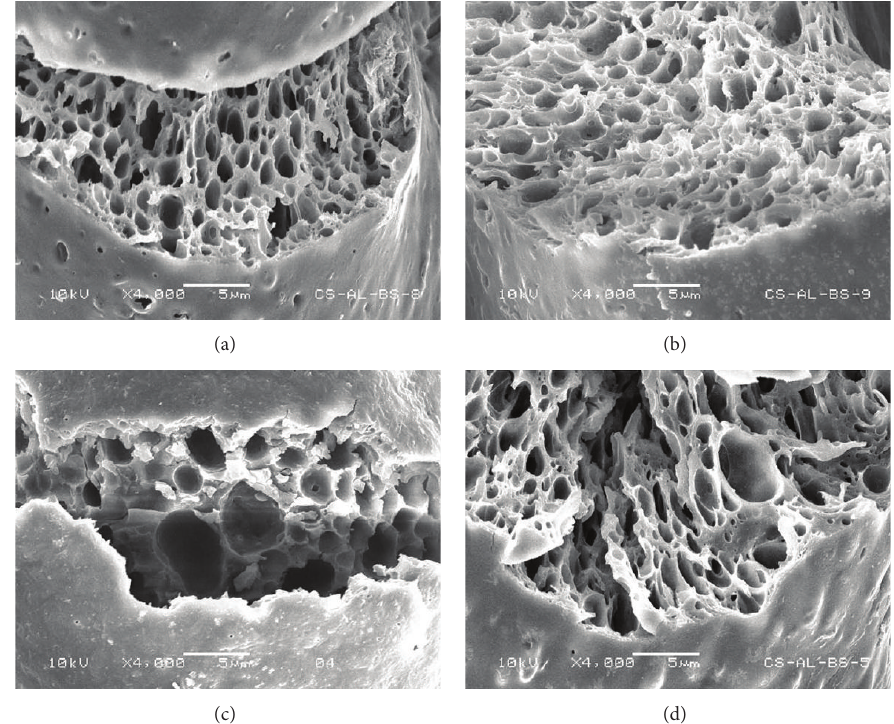
Figure 3: SEM images of broken drug-free microspheres of (a) 15 kDa chitosan, (b) 100kDa chitosan, (c) potato starch, and (d) alginate. All bars = 5 𝜇